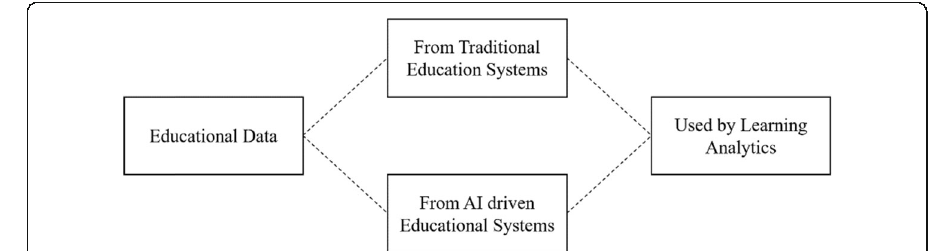
Fig. 1 Relationship between EDM and LA (Renz et al.,